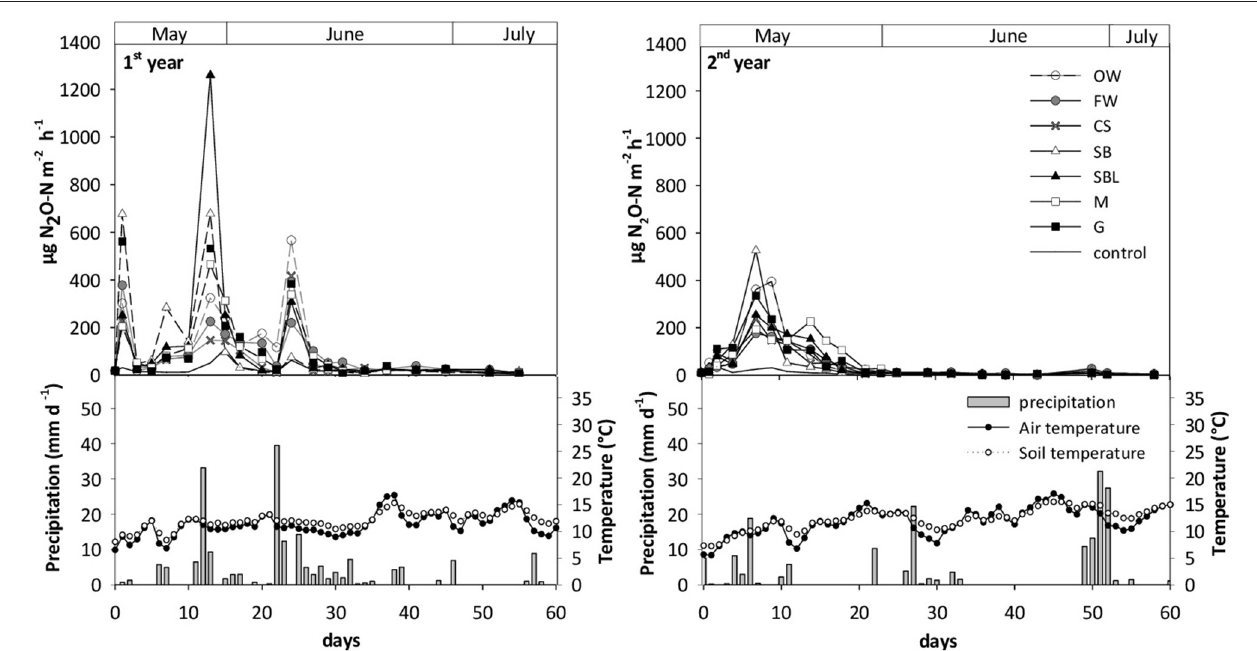
FIGURE 1 | Mean daily N 2 O fluxes after application of different digestates based on organic waste (OW), food waste (FW), cattle slurry (CS), sugar beet (SB), sugar beet leaves (SBL), maize (M), grass (G), and unfertilized soil (control) measured from May to July 2016 and 2017 (1st and 2nd year) at Heidfeldhof. Digestate application of 170kg N ha − 1 on day 1. Standard error of measurements was excluded due to improved clarity, but shown in 15 N fluxes ( Figures 2 , 3 ). Climate data with mean daily precipitation on the left y-axis and mean daily temperature on the right y-axis.